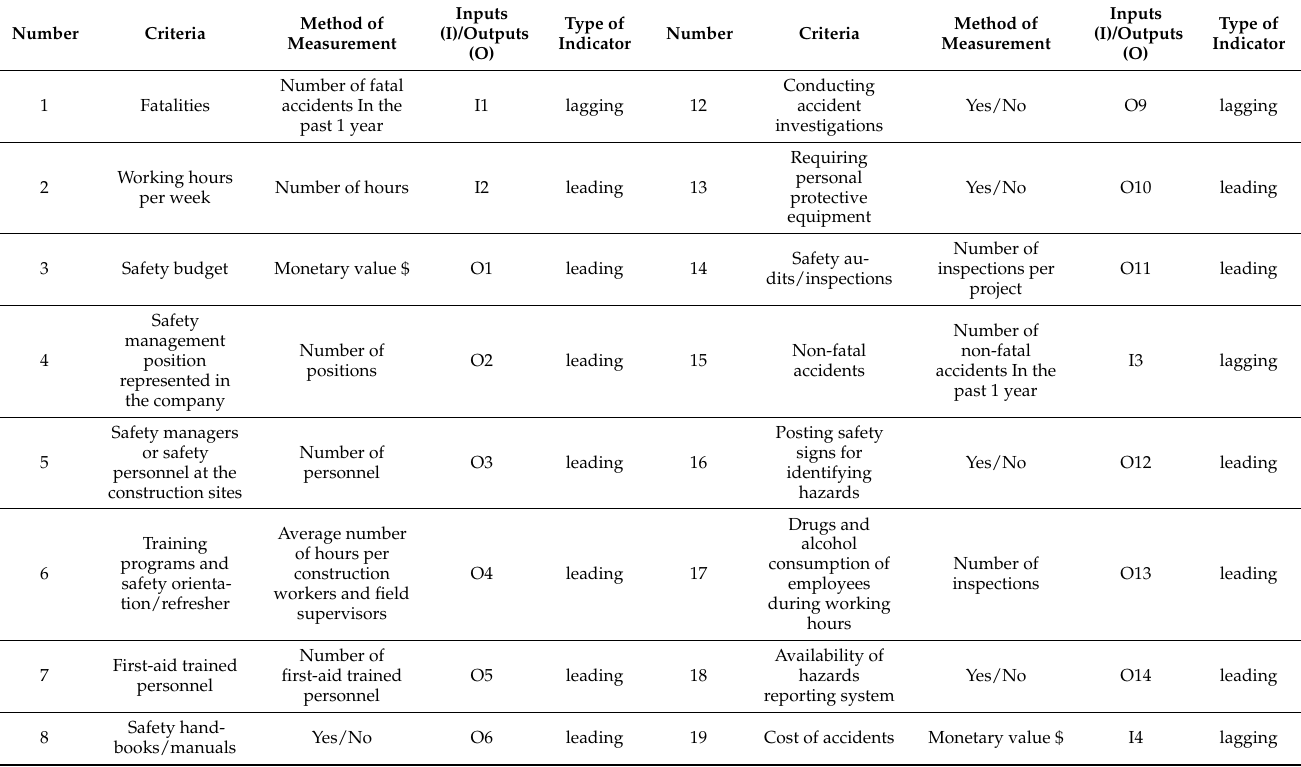
Table 1. A list of safety performance